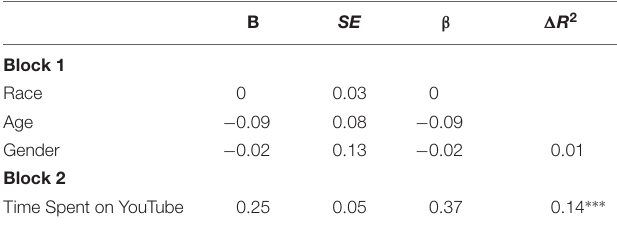
TABLE 5 | Summary of hierarchical regression for time spent on YouTube predicting parasocial relationships.